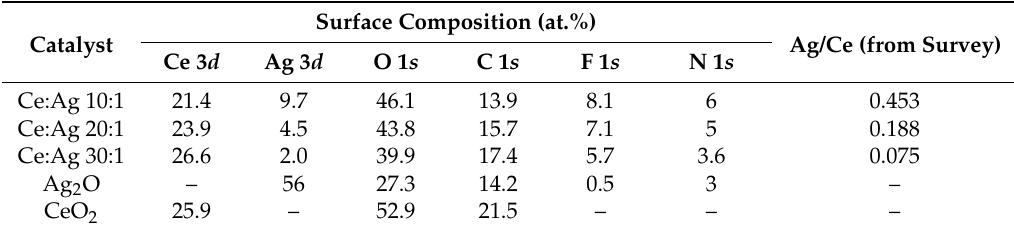
Table 2. Surface elemental composition of Ag doped CeO 2 , Ag 2 O, and CeO 2 thin films. Surface Composition Catalyst